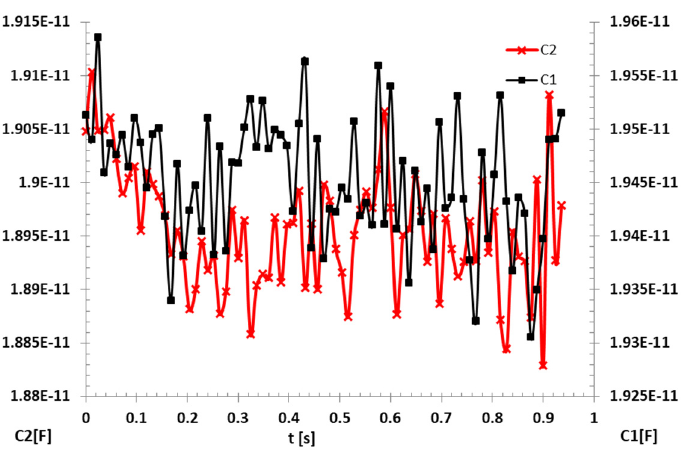
Figure 6. The evolution of measured capacities during slush transfer.